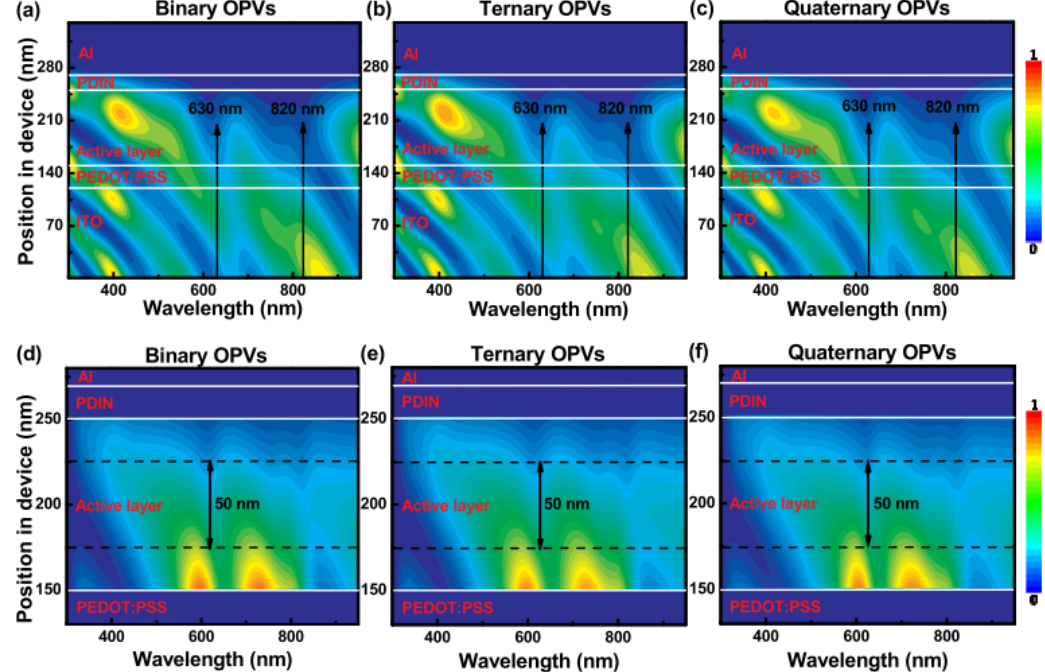
Figure 11. The simulated optical field distribution in the ( a ) binary, ( b ) ternary and ( c ) quaternary OPVs; calculated photogenerated exciton distribution in the optimized active layers of ( d ) binary, ( e ) ternary and ( f ) quaternary OPVs. Reproduced from [101]. Reprinted with permission from ref. [101]. Copyright 2020 Elsevier.